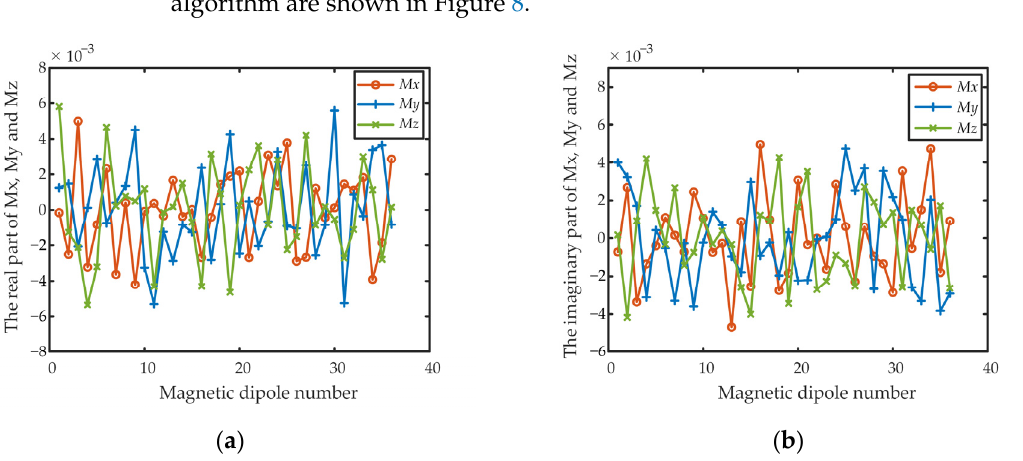
Figure 8. The values of the real and imaginary parts of the magnetic dipole moment. ( a ) The values of the real part of the magnetic dipole moment; ( b ) The values of the imaginary part of the magnetic dipole moment.